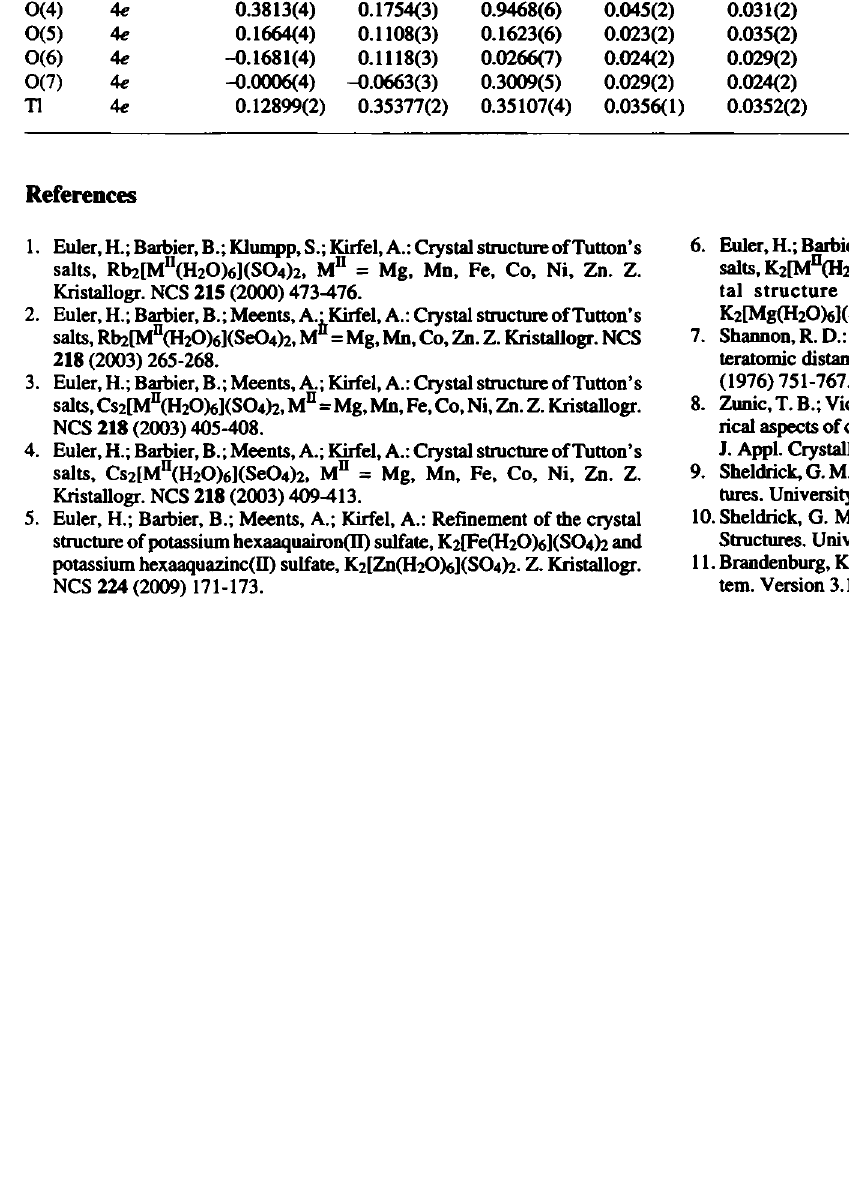
Table 18. Atomic coordinates and displacement parameters (in A 2